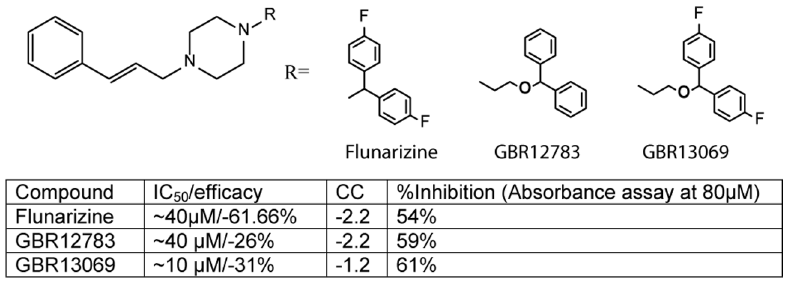
Figure 1. PyeADHII inhibitors identified in the HTS. Top, structure of inhibitors, bottom table shows the potency data. CC = qHTS curve class. None of the compounds showed autofluorescence.